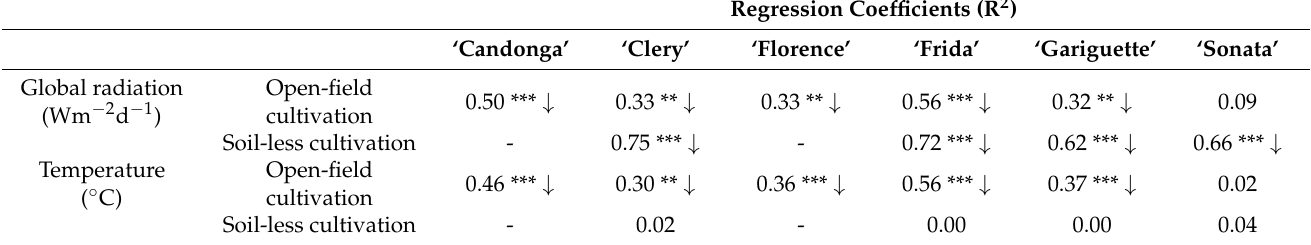
Table 2. Regression coefficients (R 2 ) for the date of flower initiation related to global radiation and temperature in six strawberry cultivars during the 3-week period preceding flower initiation when grown at five locations in Europe. Regression Coefficients (R 2 ) ‘Candonga’ ‘Clery’ ‘Florence’ ‘Frida’ ‘Gariguette’